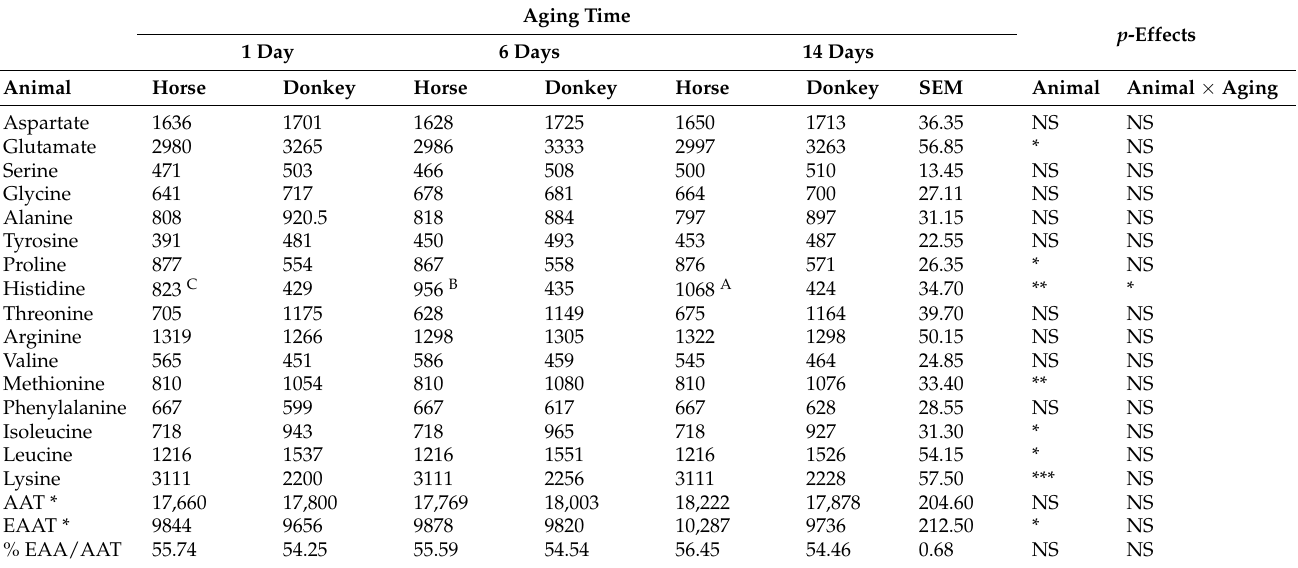
Table 6. Amino acids composition (mg/100g of meat) of horse and donkey meat during aging time (means ± SEM). Aging